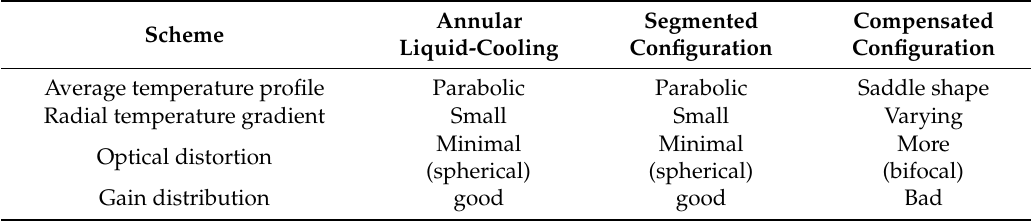
Table 4. The performance of the laser rods in three side-pumping